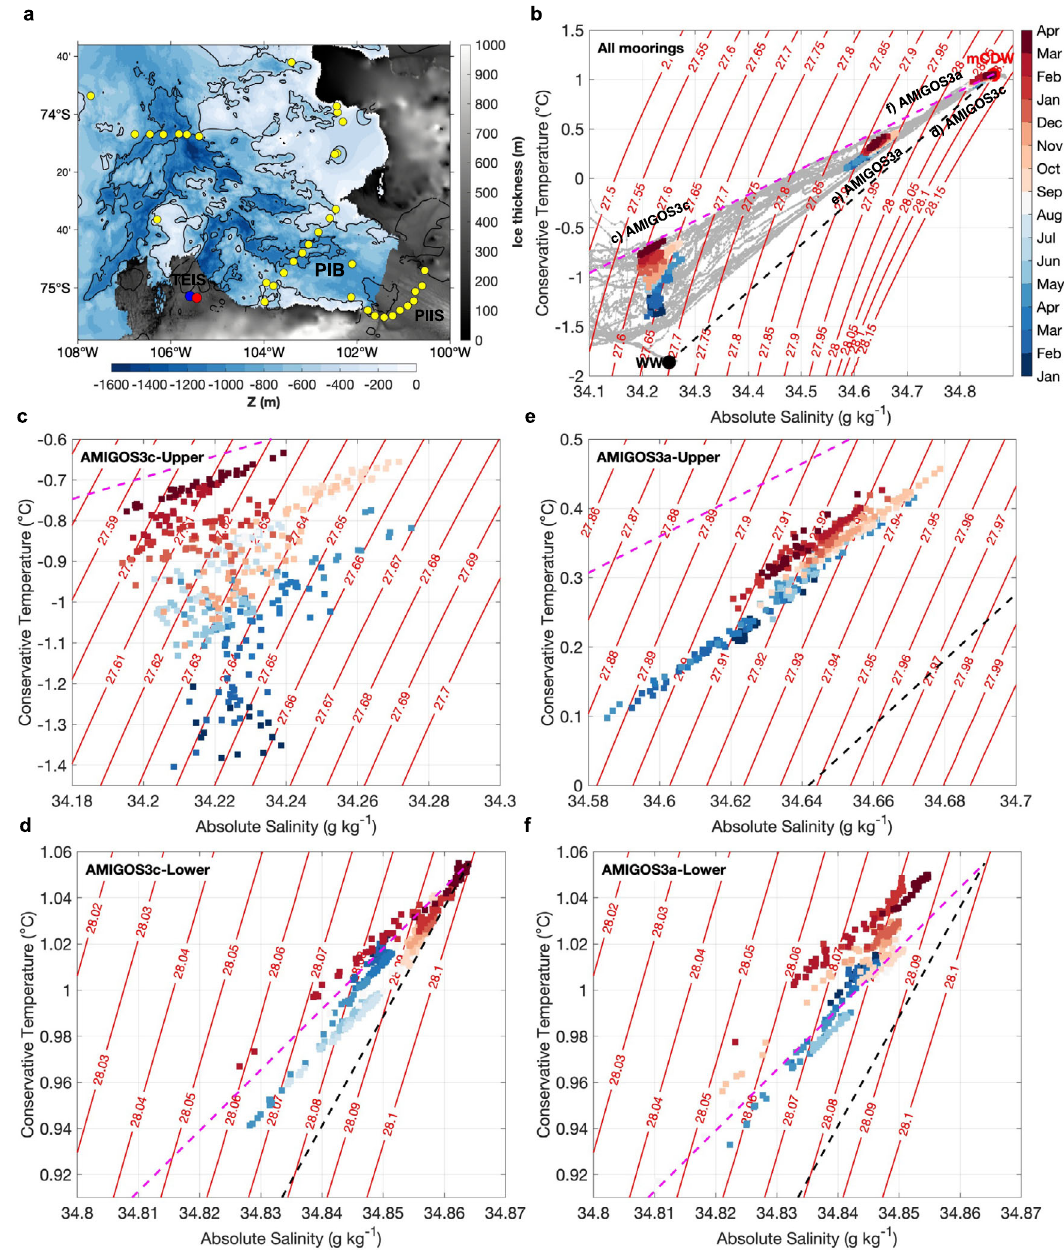
Fig. 2 | ConservativeTemperature-AbsoluteSalinity-Timediagrams.a Location ofConductivity-Temperature-Depth(CTD)stations(yellowdots)inPineIslandBay (PIB) collected in January and February 2020, and the AMIGOS3a (blue dot) and AMIGOS3c(reddot)sites.ThwaitesEasternIceShelf(TEIS)andPineIslandIceShelf (PIIS) are depicted. Ice thickness and bathymetry from BedMachine Antarctic v2, ref. 37. Note that BedMachine is not updated to the most recent calving front.